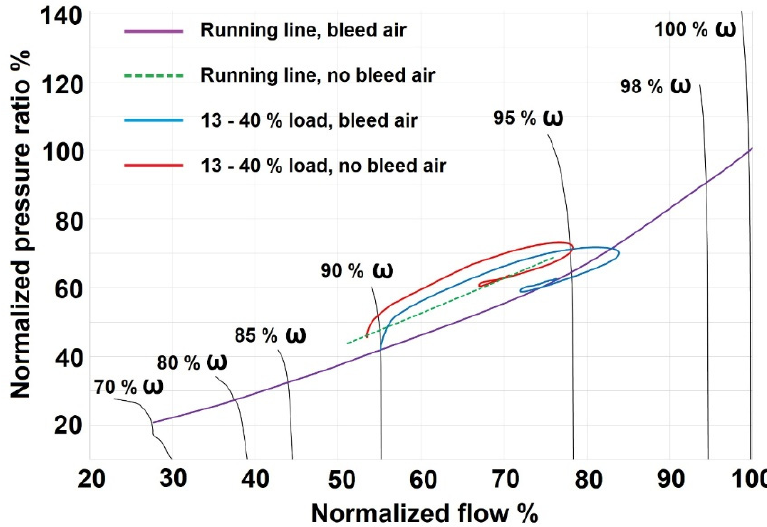
Figure 11. Representation of transient compressor response on compressor performance map for 13–40% load with/without bleed air. The transient response during load acceptance maneuver from 13–40%, and 26% to 53% with center case bleed e ff ect is shown in Figure 12.